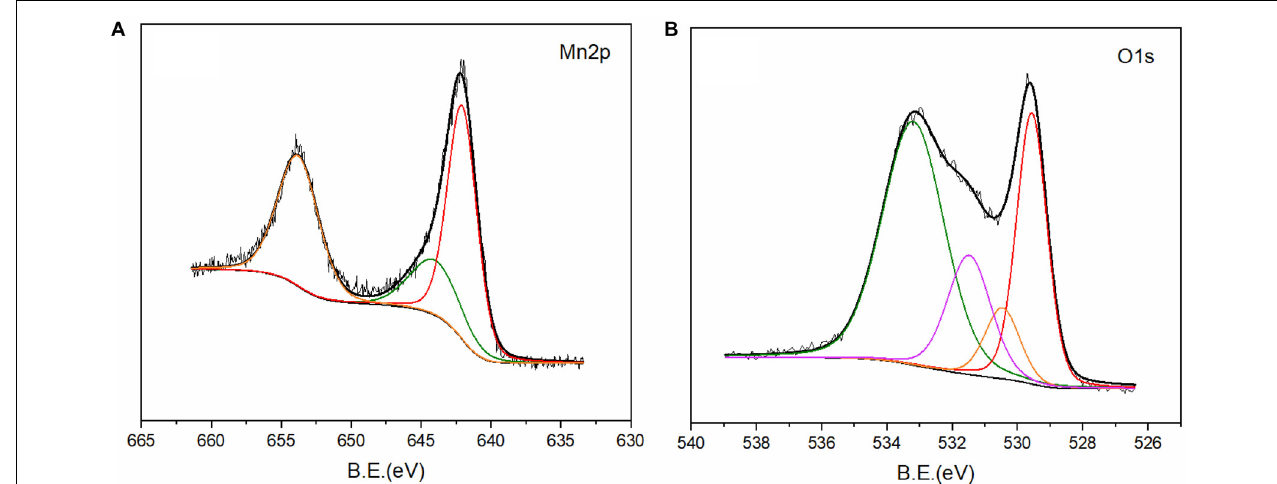
FIGURE 5 | XPS spectra of BC/MnO 2 : (A) Mn2p and (B) O1s.